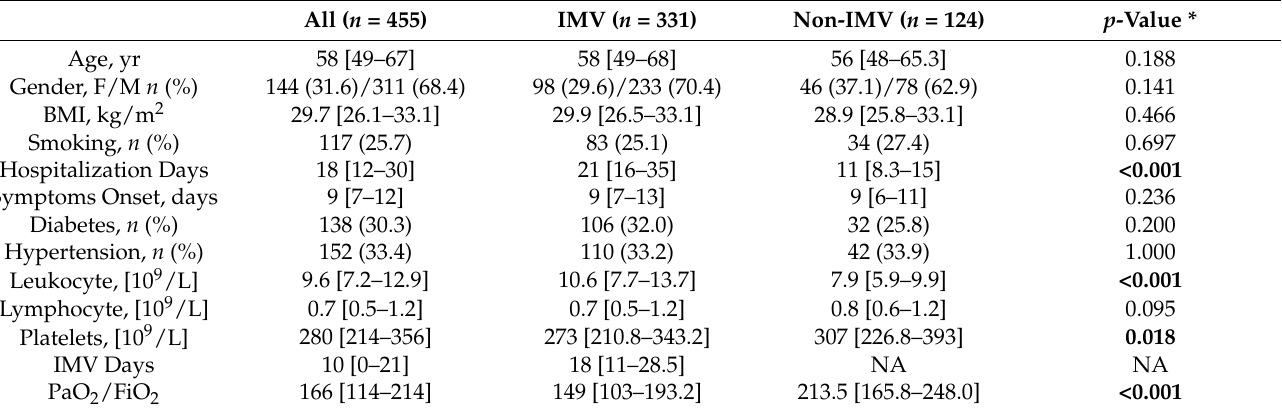
Table 1. Demographic and clinical data of patients with COVID-19 included in the